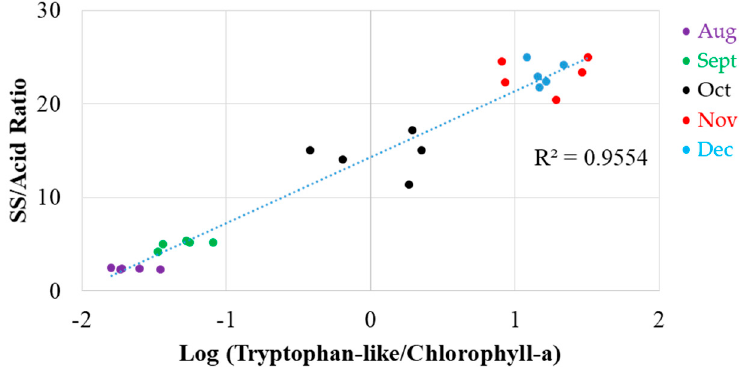
Figure 7. Logarithmic correlation between the ratio of tryptophan-like/chlorophyll-a (Ex 260 nm and Em 330 nm divided Ex 410 nm and Em 675 nm) and SS/acid ratio.